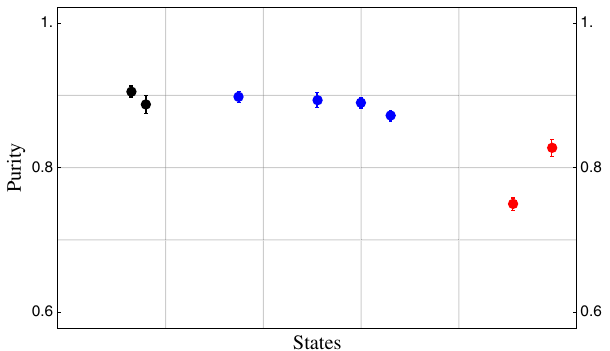
FIG. 6. Purity of the three-qubit states. The blue, red, and black dots are the W , GHZ , and BS states prepared, respectively. The error bars are also shown.